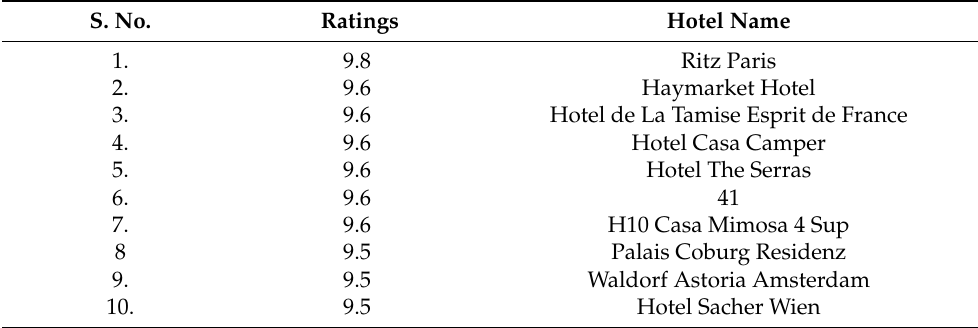
Table 8. Top-10 recommended hotels for the 1493 hotels of booking.com based on the average numerical ratings of